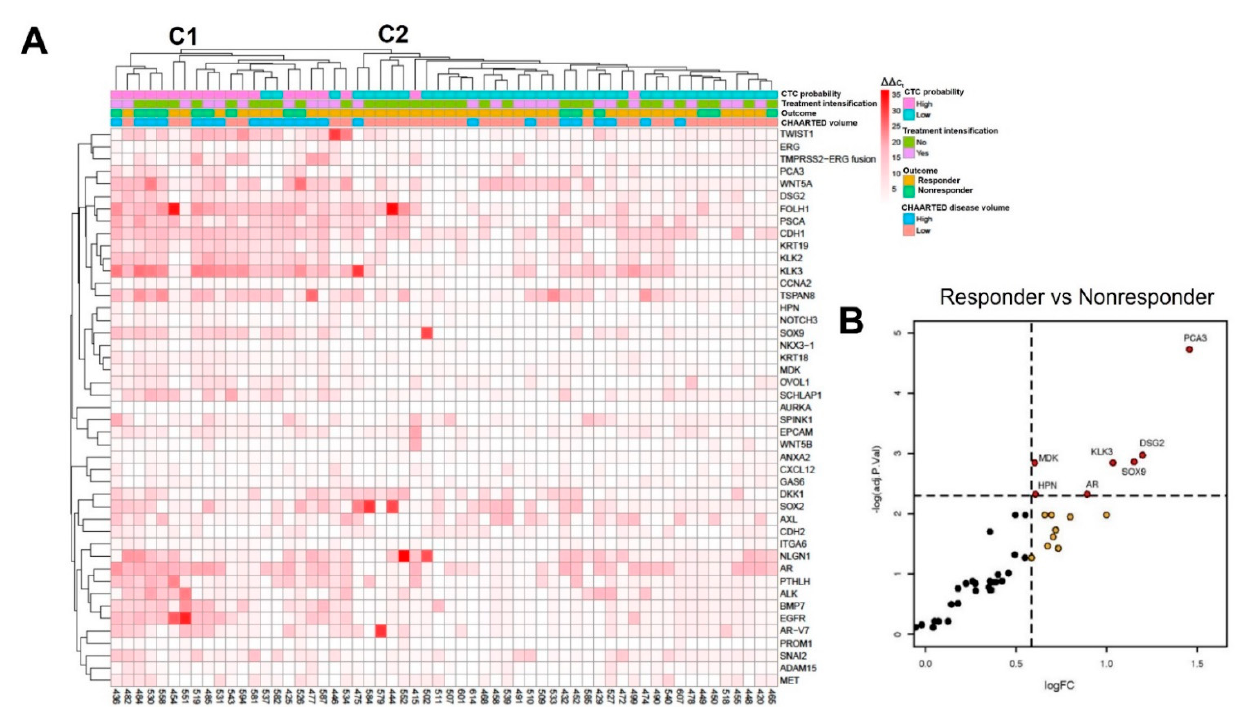
Figure 1. Heatmap of MiCoPilot patient gene expression prior to initiation of ADT ( A ). Unsuper- vised clustering of normalized gene expression was conducted using the ward.D2 clustering. CTC probability was determined using 5 epithelial genes as described in the methods. Patient character- istics, including treatment intensification and CHAARTED volume, and patient outcomes (re- sponder/nonresponder) are annotated above the heatmap, and deidentified patient ID numbers and interrogated genes are annotated on the bottom and right of the heatmap, respectively. Volcano plot ( B ) showing differentially expressed genes that were significantly (FDR < 10% and LogFC > 0.585) enriched in nonresponders compared with responders. Table 4. Area under the curve (AUC) values are given for differentially expressed genes between responders and nonresponders across all patients (Total Cohort), as well as within key subgroups. These subgroups included patients with a high CTC probability (CTC high ), patients who received ADT monotherapy (ADT mono ), patients who received treatment intensification (Intensificaiton), all CHAARTED high-volume patients (HV), CHAARTED HV patients who received ADT monother- apy (HV ADT mono ), and CHAARTED HV patients who received treatment intensification (HV In- tensification). The top 6 scoring genes for each cohort are highlighted in bold-underline font, and the top 5 scoring genes in common between all cohorts are highlighted in grey in the gene column.